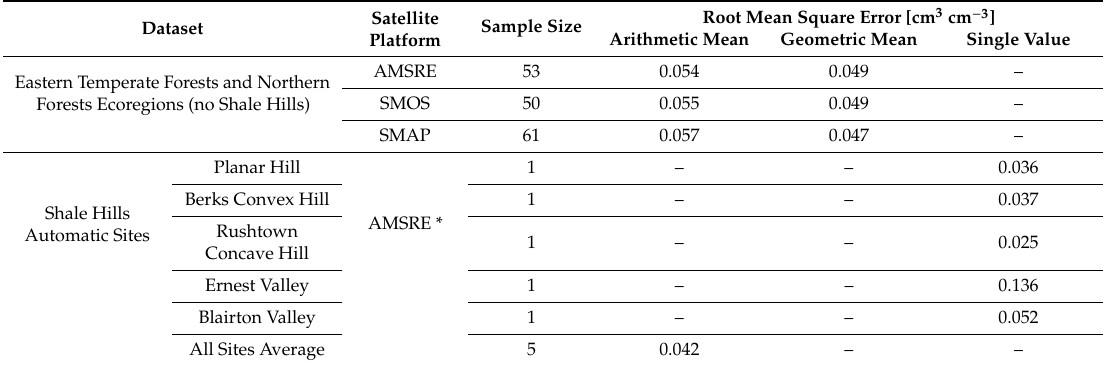
Table 4. Model corroboration and validation RMSE metrics for the regional SMAR model at the training sites (top half) and at the Shale Hills (bottom half), respectively.